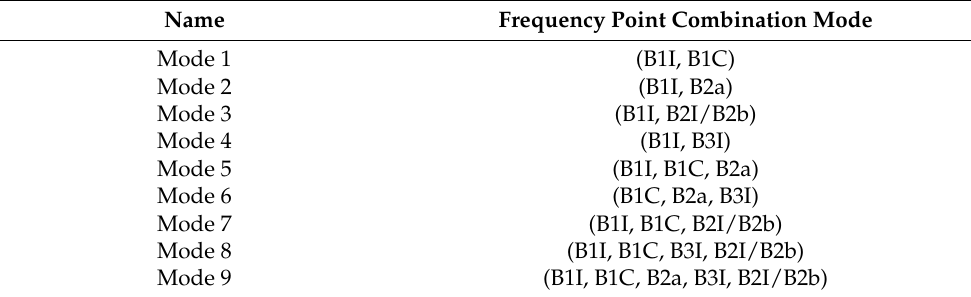
Table 5. Frequency combinations in different modes.